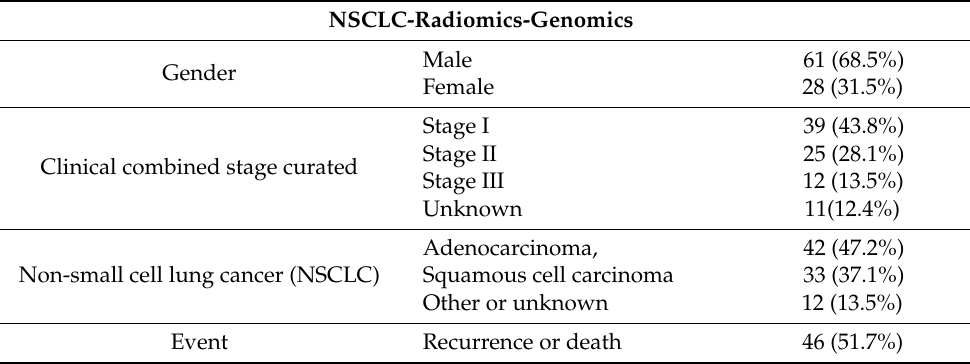
Table 1. Clinical and demographic data including gender, type of NSCLC, and stage of cancer for collected patients in NSCLC-Radiomics-Genomics (Harvard) lung dataset is